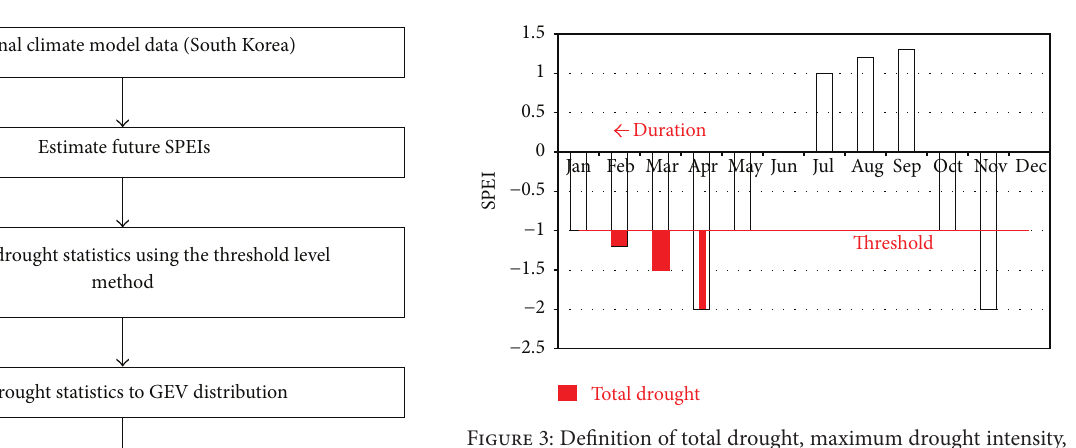
Figure 3: Definition of total drought, maximum drought intensity, and drought